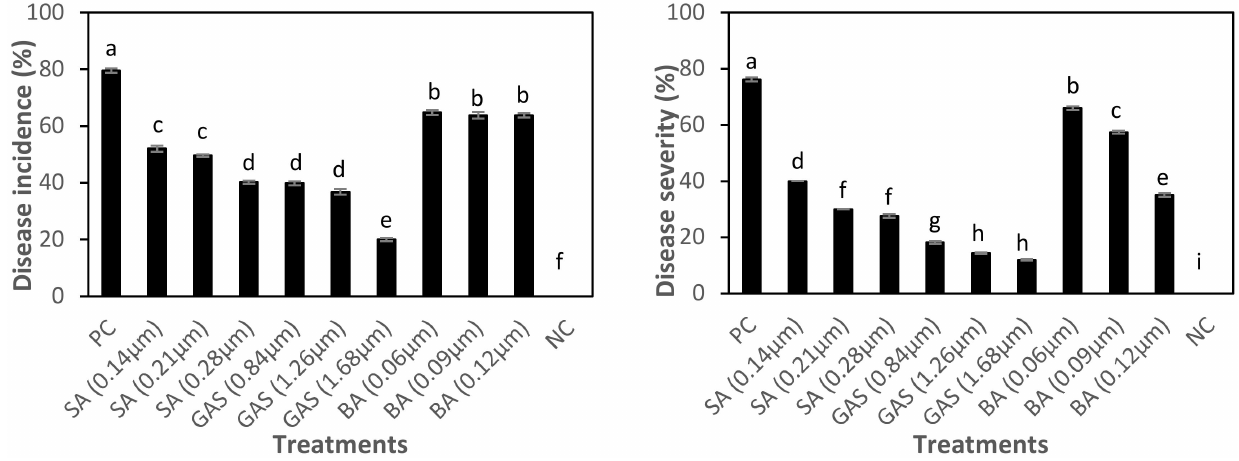
Figure 7. Variation in disease incidence and severity in negative control plants (NC), positive control plants (PC), and in response to foliage application of nano-salicylic acid (SA; 0.14, 0.21, and 0.28 µ M), nano-glycyrrhizic acid ammonium salt (GAS; 0.84, 1.26, and 1.68 µ M), and nano-boric acid (BA; 0.06, 0.09, and 0.12 µ M) to phytoplasma-infected faba bean plants. Means followed by the same letter in each column were not significantly different according to Duncan’s multiple range test ( p ≤ 0.05).